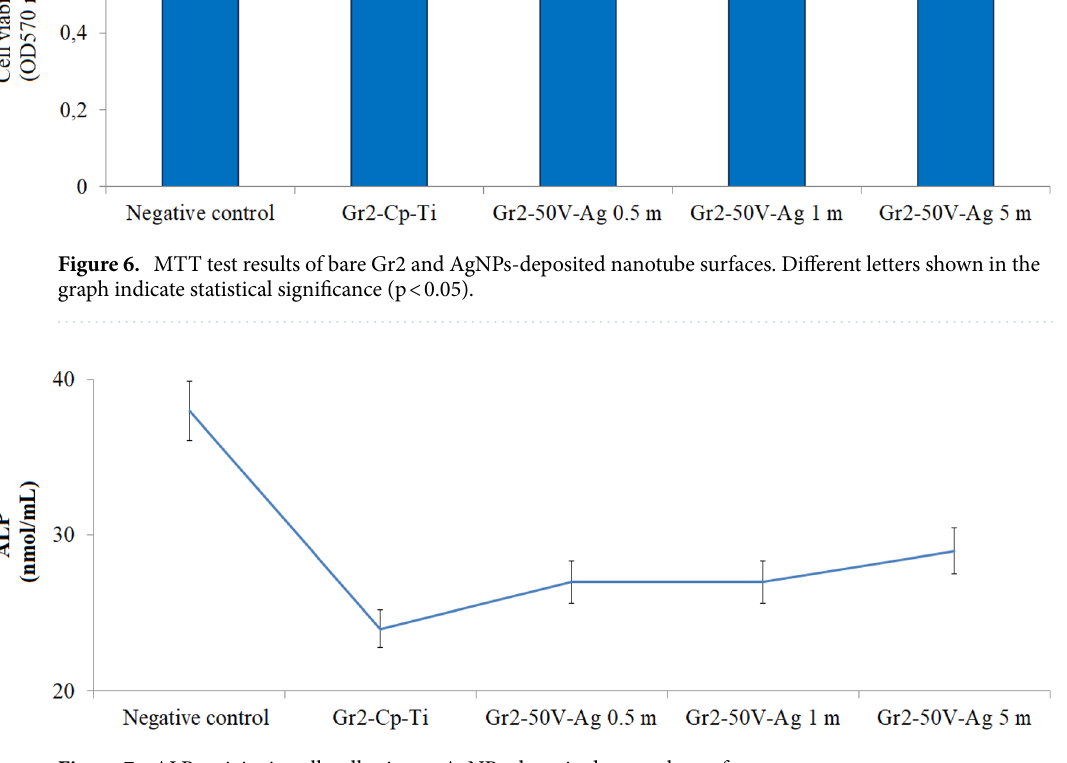
Figure 7. ALP activity in cells adhering to AgNPs-deposited nanotube